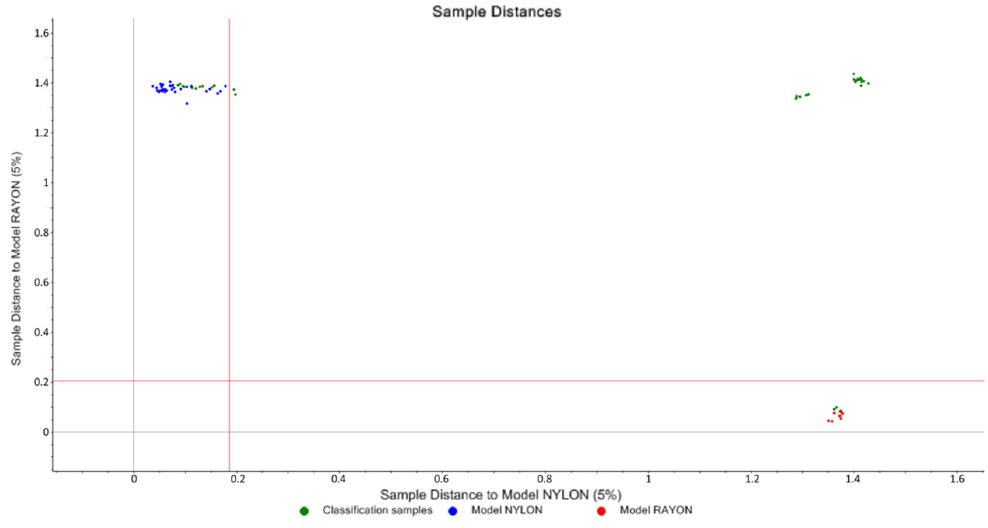
Figure 7. Nylon vs. rayon Cooman’s